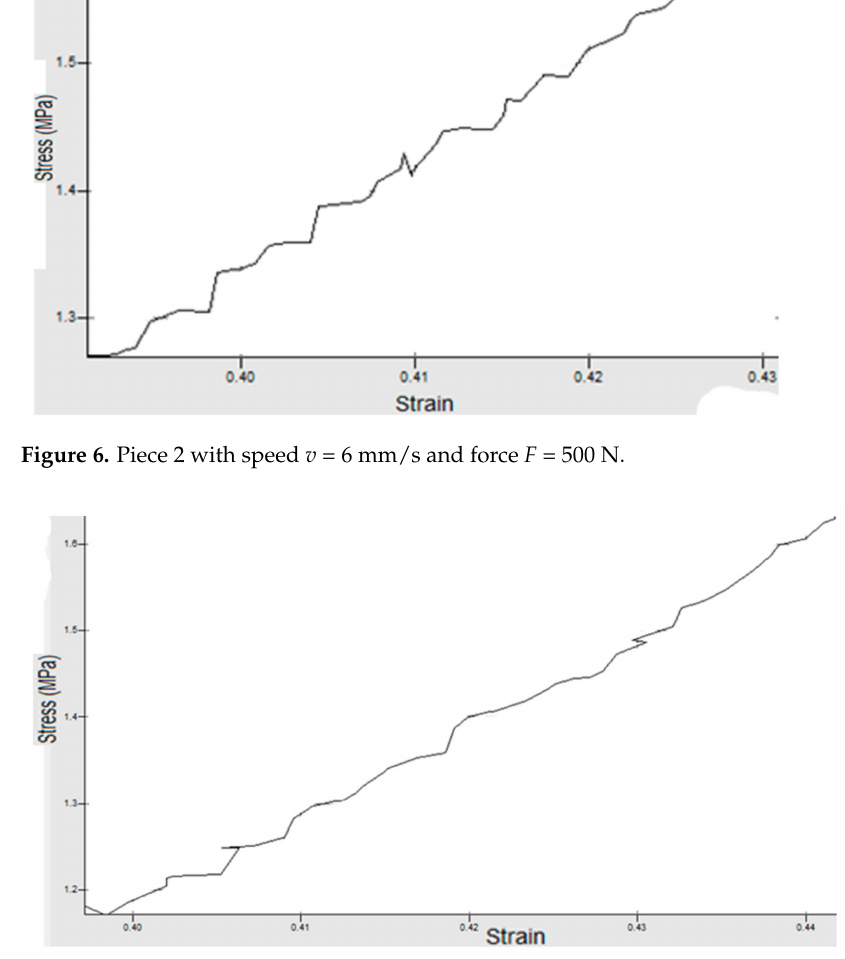
Figure 7. Piece 3 with speed v = 7 mm/s and force F = 510